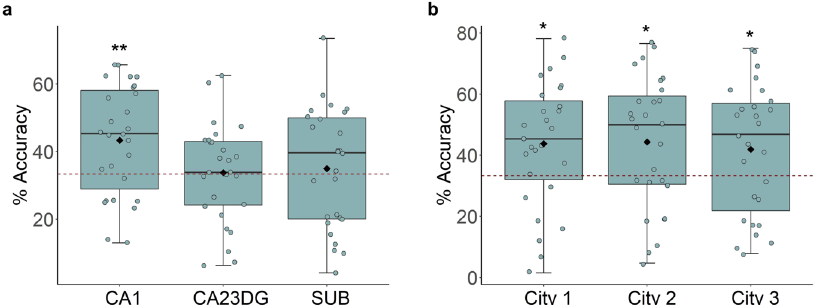
Fig. 5 Environment-speci fi c representations in CA1. a The SVM classi fi er revealed overall classi fi cation accuracy in CA1 (across all cities) was well above chance (t(26) = 3.222, p = 0.009, two-tailed one-sample t -test compared to chance level = 33.33% which survived FDR correction). b Testing each city ’ s classi fi er performance against chance in CA1 revealed that the classi fi er performed above chance on all cities (City 1: p = 0.020, City 2: p = 0.020, City 3: p = 0.045, two-tailed one-sample t-test compared to chance level = 33.33% with FDR correction). Notes: Boxplots are centered on the median, boxes extend to fi rst and third quartiles, whiskers extend to 1.5 times the interquartile range or minima/maxima in the absence of outliers. Each un fi lled dot represents data from an individual subject. Each black solid diamond represents the mean of the group. All data re fl ect n = 27 independent participants. mSUB subiculum. * p < 0.05, ** p < 0.01. Source data are provided in the Source Data fi